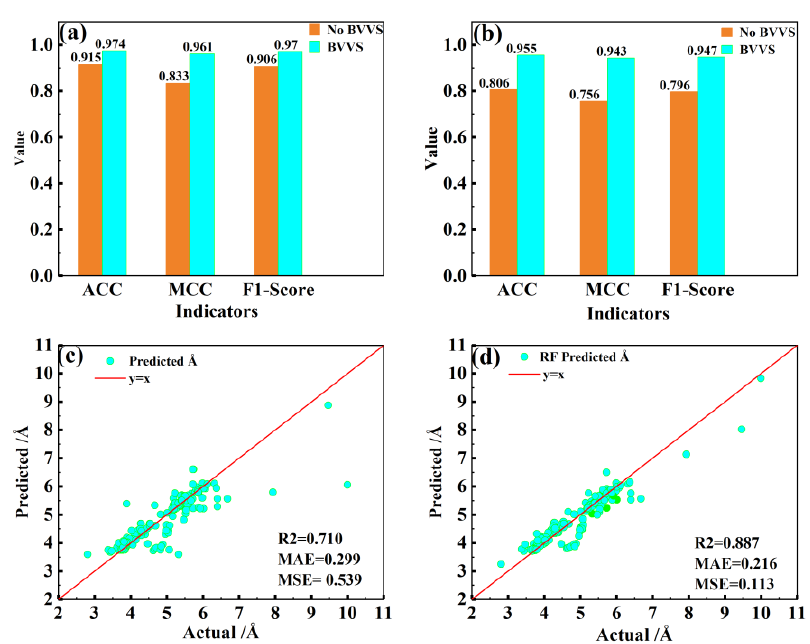
Figure 2. Experimental results before and after adding BVVS: ( a ) crystal system; ( b ) space group; ( c ) the lattice constant a before adding BVVS; ( d ) the lattice constant a after adding BVVS.